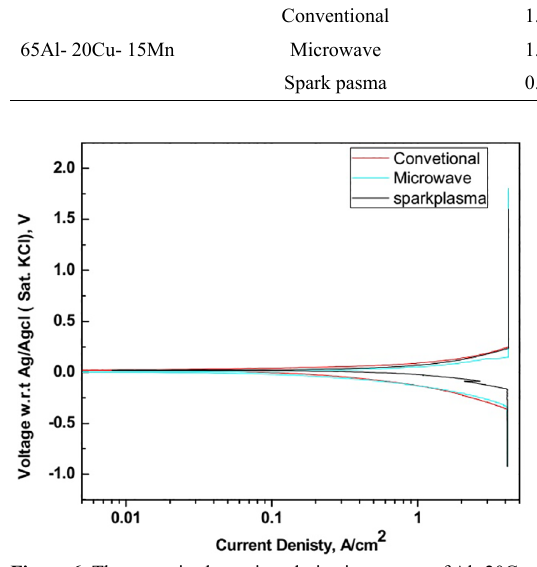
Figure 6. The potentio-dynamic polarization curves of Al -20Cu- 15Mn compact sintered at 525° was homogeneous in the microstructure (Figure 3(c)) 33 .